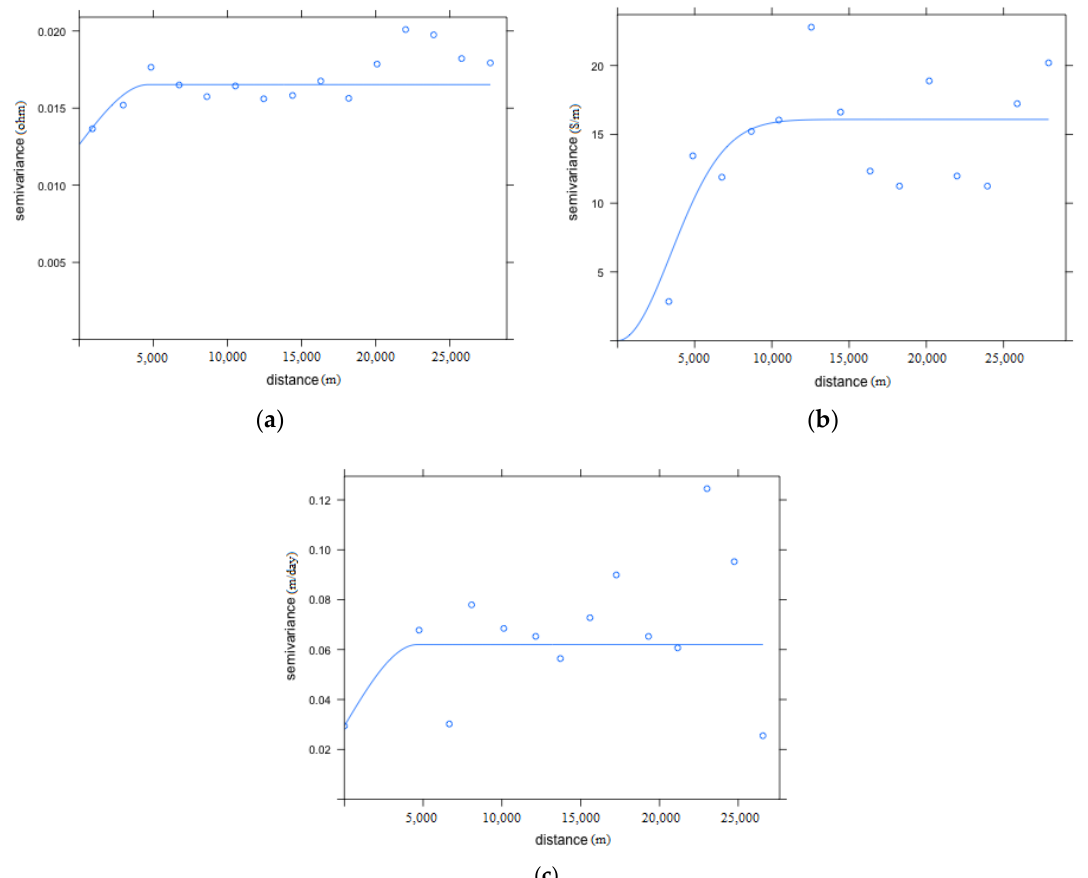
Figure 4. Variogram fittings of collected vertical electrical resistivity, pore water electrical conductivity, and hydraulic conductivity. ( a ) Variogram fitting of vertical electrical resistivity; ( b ) variogram fitting of water electrical conductivity; ( c ) variogram fitting of hydraulic conductivity from pumping tests.